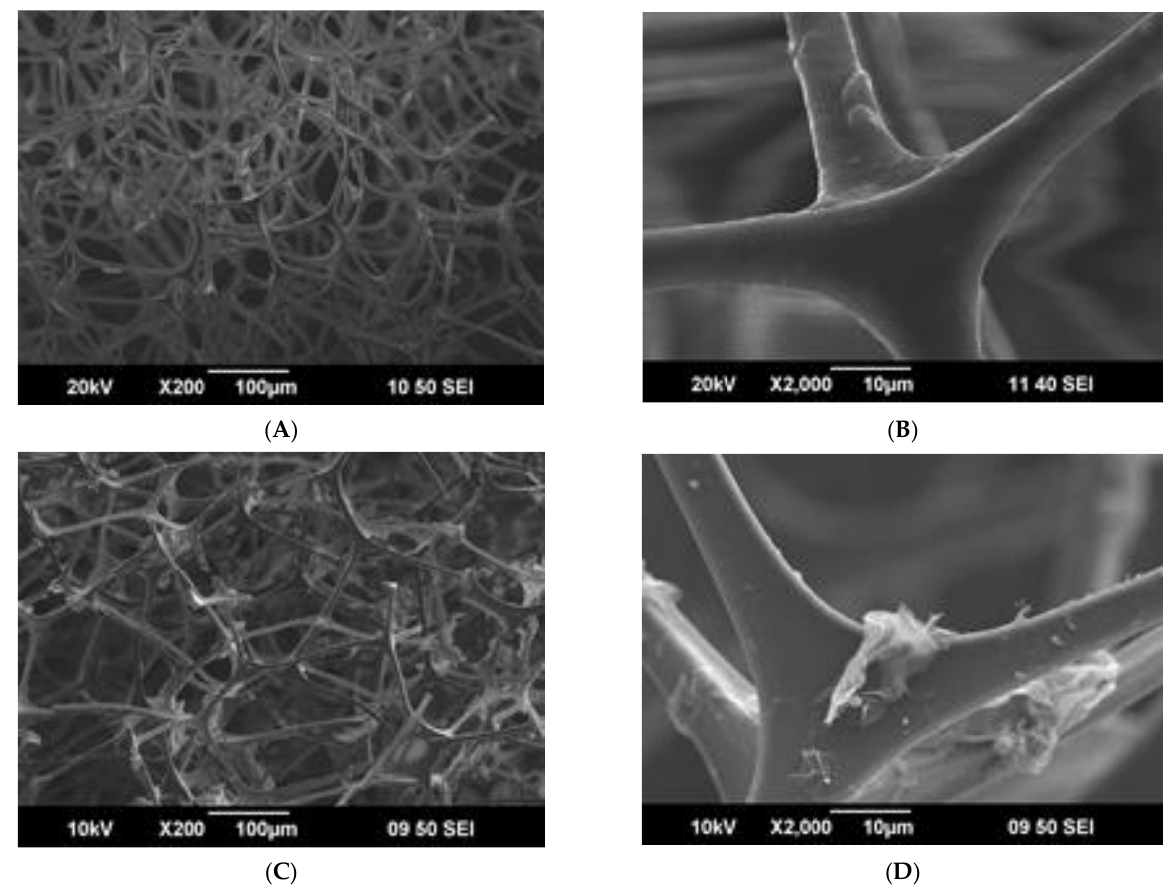
Figure 7. Scanning electron microscopy images of ( A , B ) pure melamine; ( C , D ) M – rGO – ascorb. Raman spectroscopy was used to characterize the synthesized samples. A laser with a given wavelength (633 nm) was used, as it provided a more intense spectral signal. The results are shown in Figure 8. In addition, the rGO and GO itself do not change during the measurement.